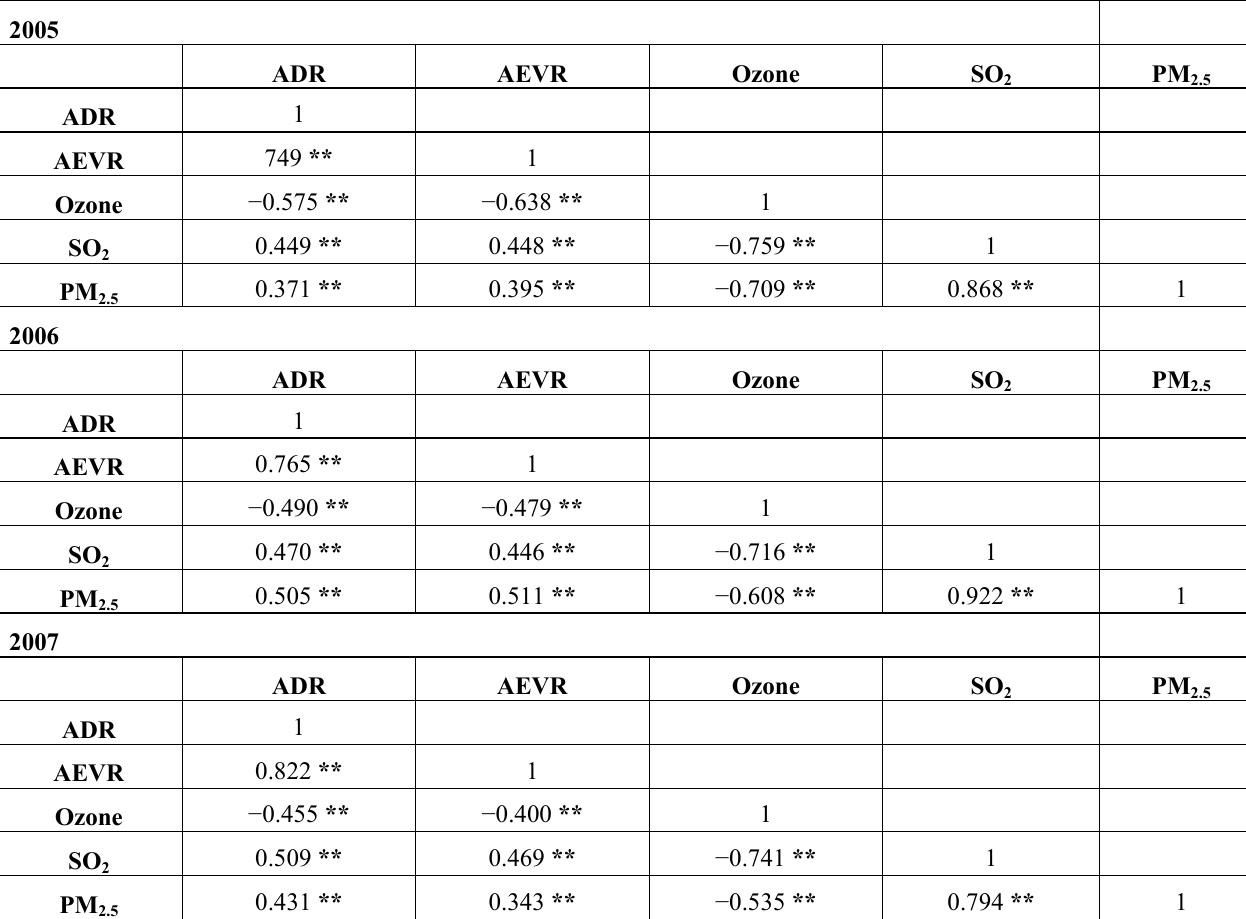
Table 5. Correlation matrix of asthma rate and air